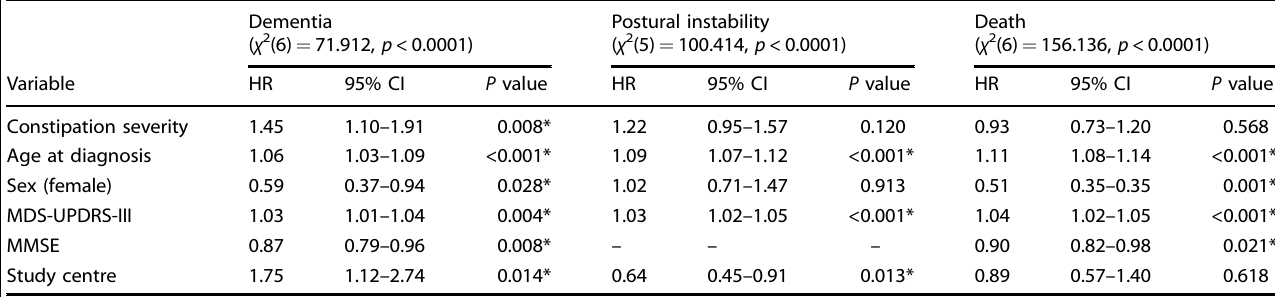
Table 2. Cox regression models of the predictive role of constipation severity on time to postural instability, dementia and death, adjusting for covariates. Dementia ( χ 2 (6) = 71.912, p <